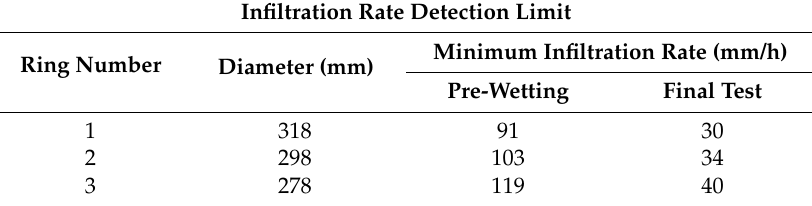
Table 2. Minimum Detection